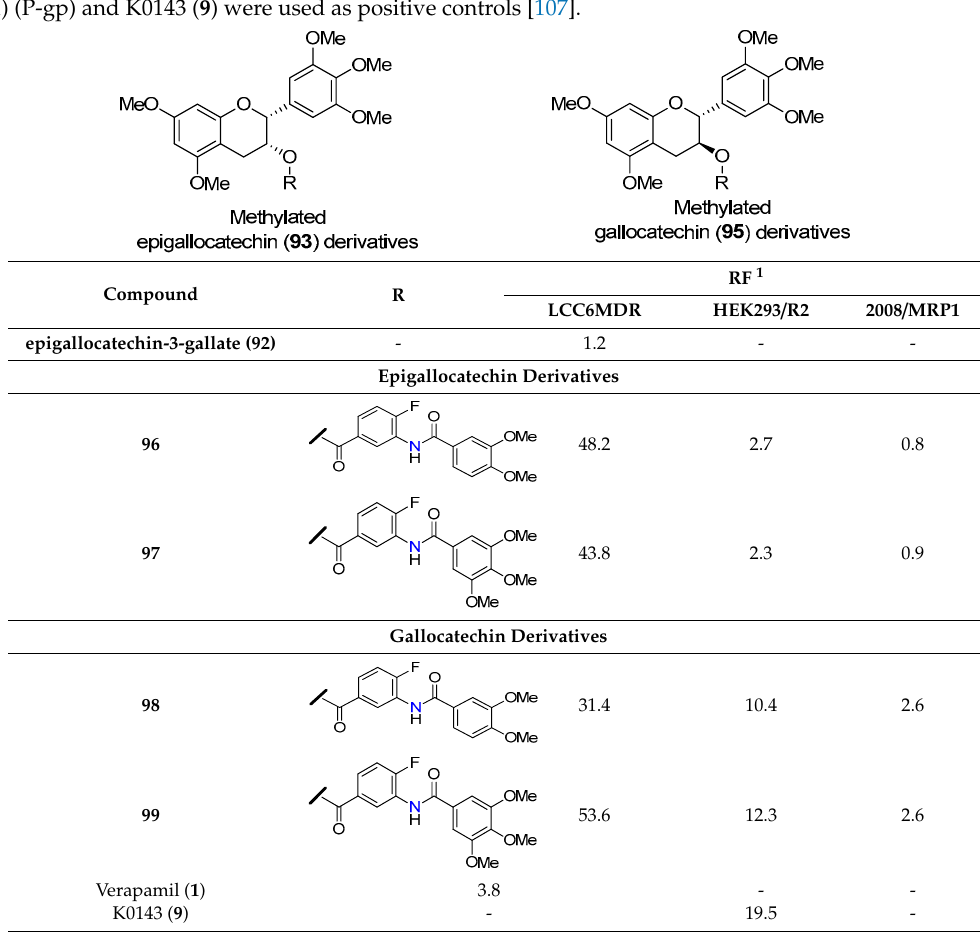
Figure 12. Structures of catechins: ( − )-epigallocatechin gallate ( 92 ), ( − )-epigallocatechin ( 93 ), ( − )- epicatechin gallate ( 94 ) and (+)-gallocatechin ( 95 ).